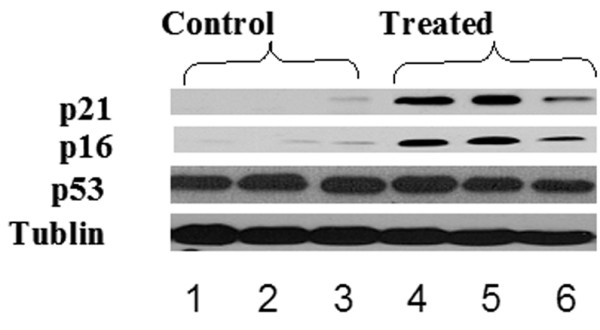
DHEA and DHEA8354 differentially affect p16, p21, and p53 protein expression: Western blot data of control tumors (lanes 1 to 3) and tumors treated with DHEA (1,000 mg/kg diet) (lanes 4 to 6) as estimated by western blotting. For western blotting, tumors were selected with relatively high values of senescence-associated β-galactosidase (SA-β-Gal)-labelled cells and low values of bromodeoxyuridine-labeled cells.